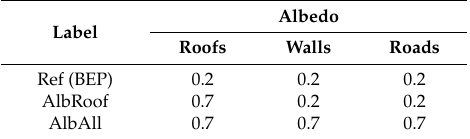
Table 3. Labels and description of the numerical